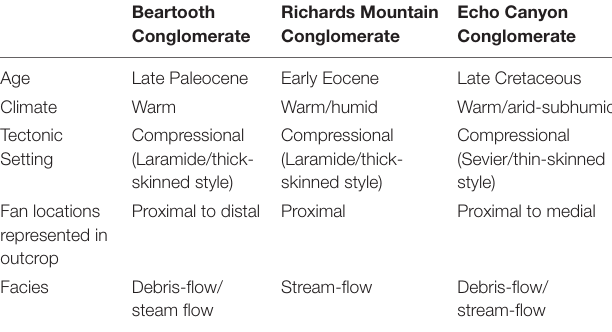
TABLE 2 | Summary of study areas.